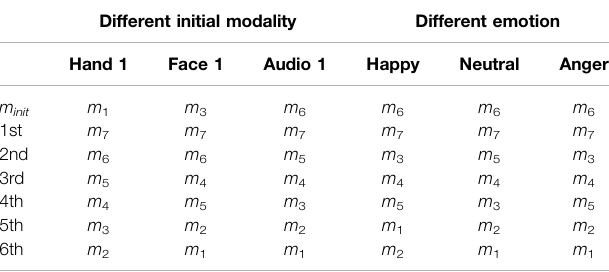
TABLE 2 | Order of modalities selected through active perception under each condition. Different initial modality Different